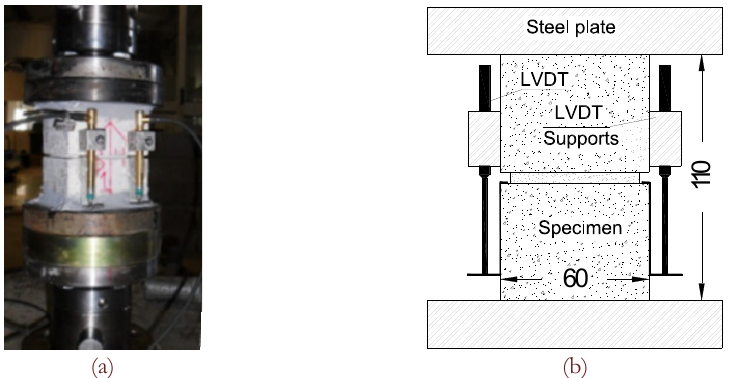
Figure 3: Uniaxial tensile test setup: (a) specimen front view, (b) specimen lateral view (units in